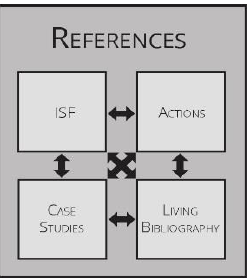
Figure 3. Interconnectivity between reference databases